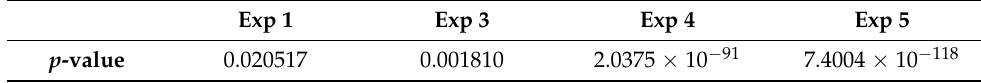
Table 2. OP-ELM models’ lowest errors statistical significance test.